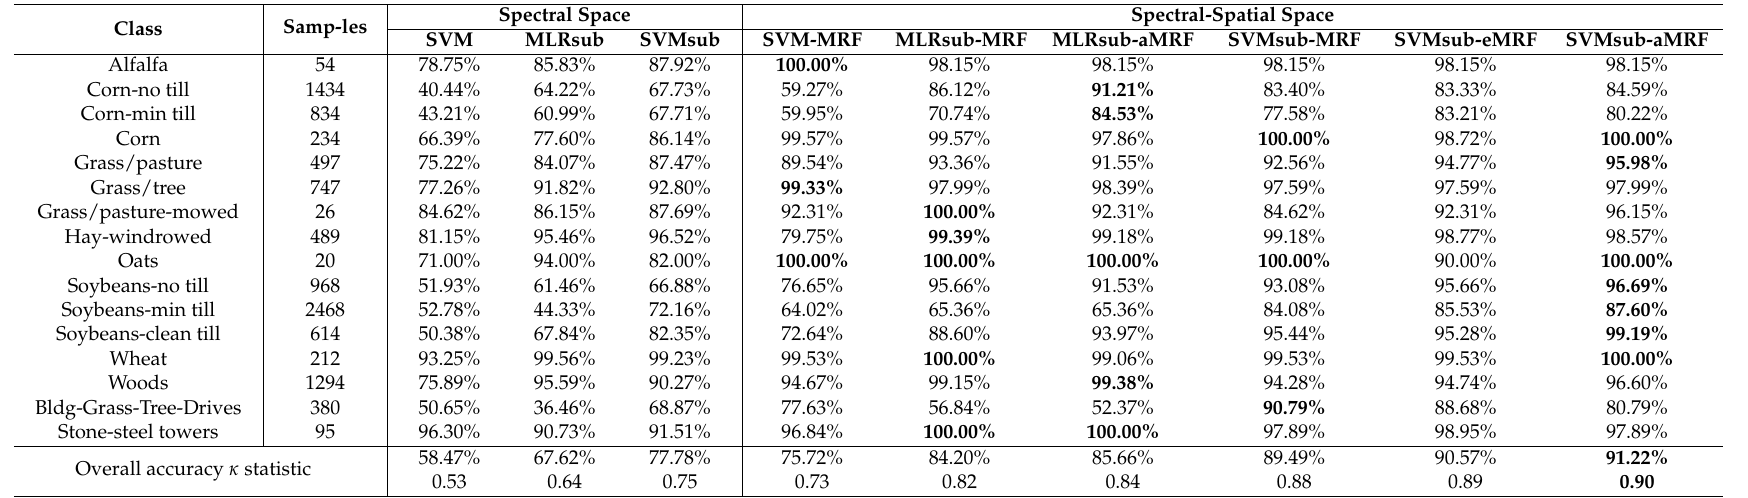
Table 1. Overall and average class accuracies and κ statistic values obtained for the Airborne Visible/Infrared Imaging Spectrometer (AVIRIS) Indian Pines data set using 220 spectral bands and a training sample size of 30 samples per class. The best results are highlighted in bold